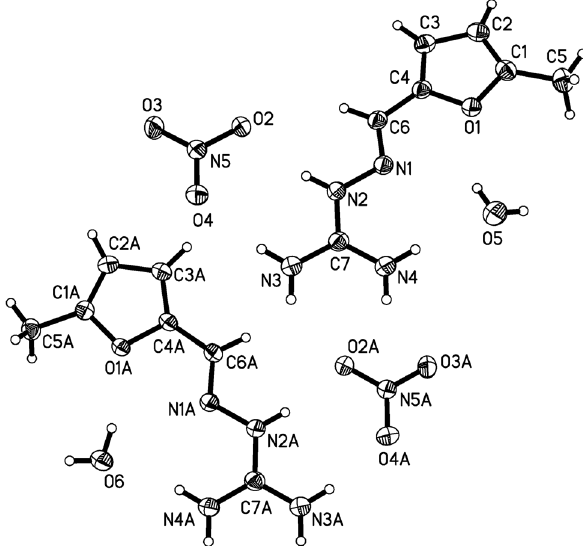
Table  : Data collection and